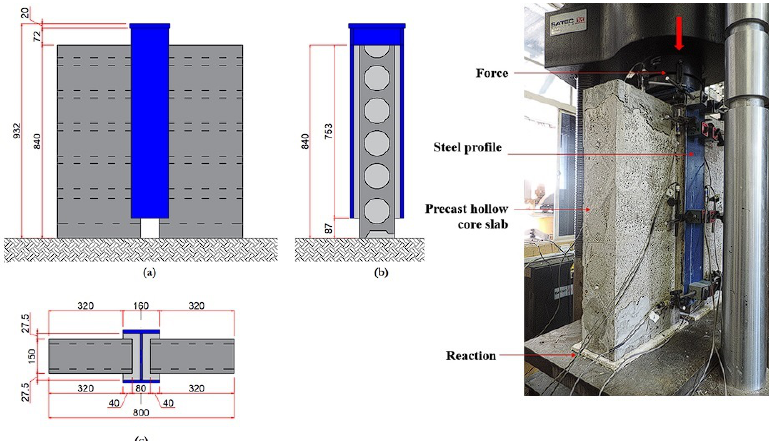
Fig. 6: Geometrical characteristics of composite cross-sections and setup of push out test - (a) Frontal view; (b) lateral view; (c) top view; (d) overview [mm]